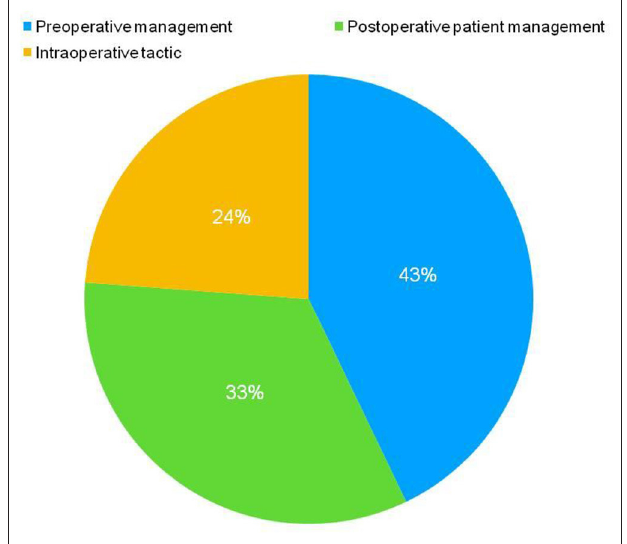
FIGURE 2 | Three main groups were chosen for proper categorization for further inferences to delineate the efficient patient management in preoperative period during DIEP flap-based breast reconstruction. This categorization was performed according to the preoperative preparation, postoperative patient management, and choice of the intraoperative